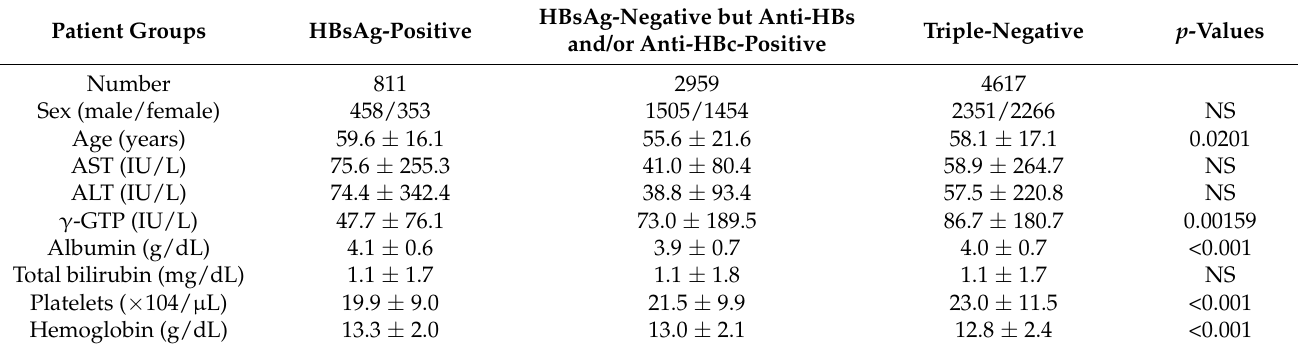
Table 1. Patient characteristics of 3 groups (HBsAg-positive, HBsAg-negative but positive for anti-HBs/anti-HBc and triple-negative